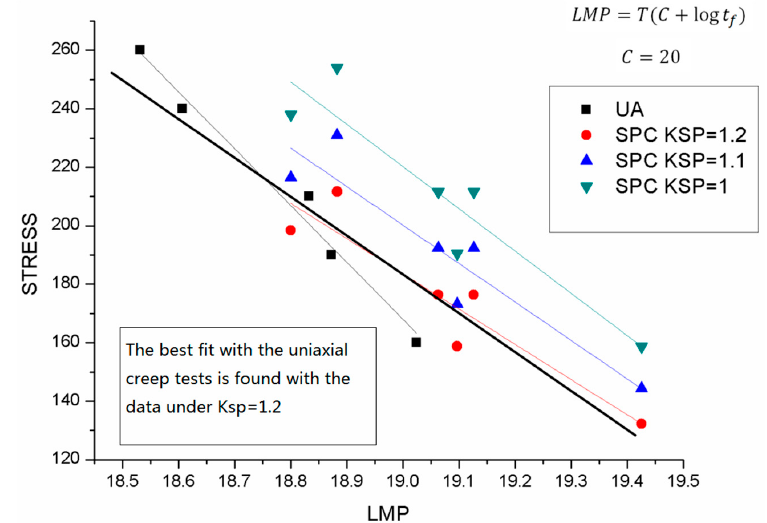
Figure 7. The Larson-Miller fitting results of both the small punch creep test and the uniaxial creep test of 16Mo3.